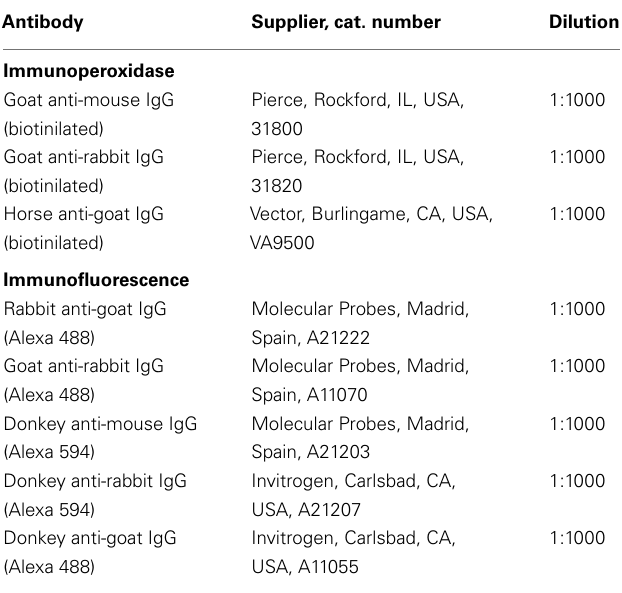
Table 2 | List of secondary antibodies used for immunohistochemistry . Antibody Supplier, cat. number